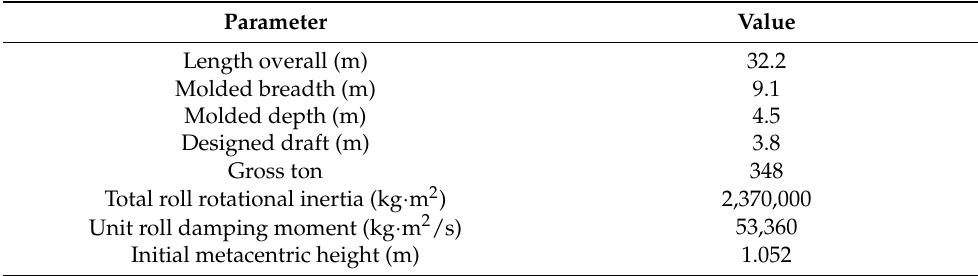
Table 2. Table 2. Dimensions of ship for simulation.